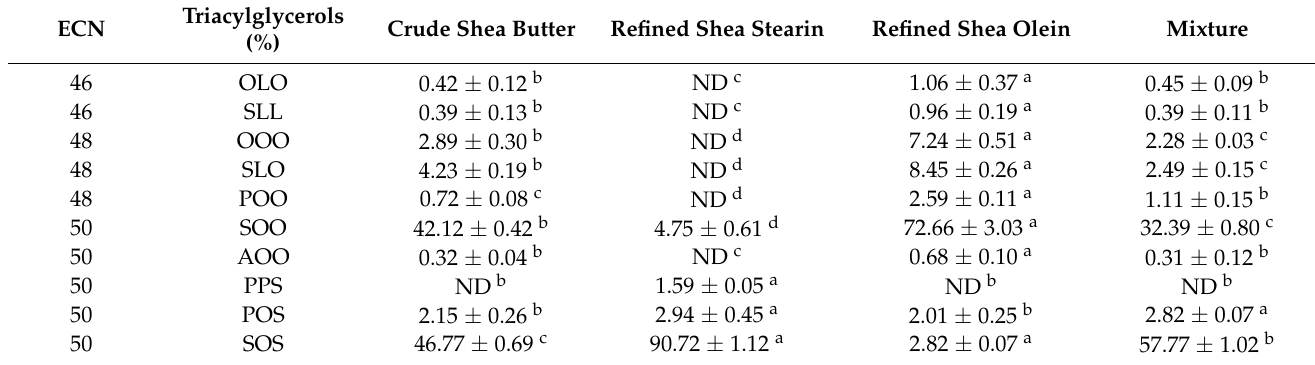
Table 2. Triacylglycerol composition (%) of crude shea butter, refined shea stearin, refined shea olein and a mixture of olein:stearin (1:1 w / w